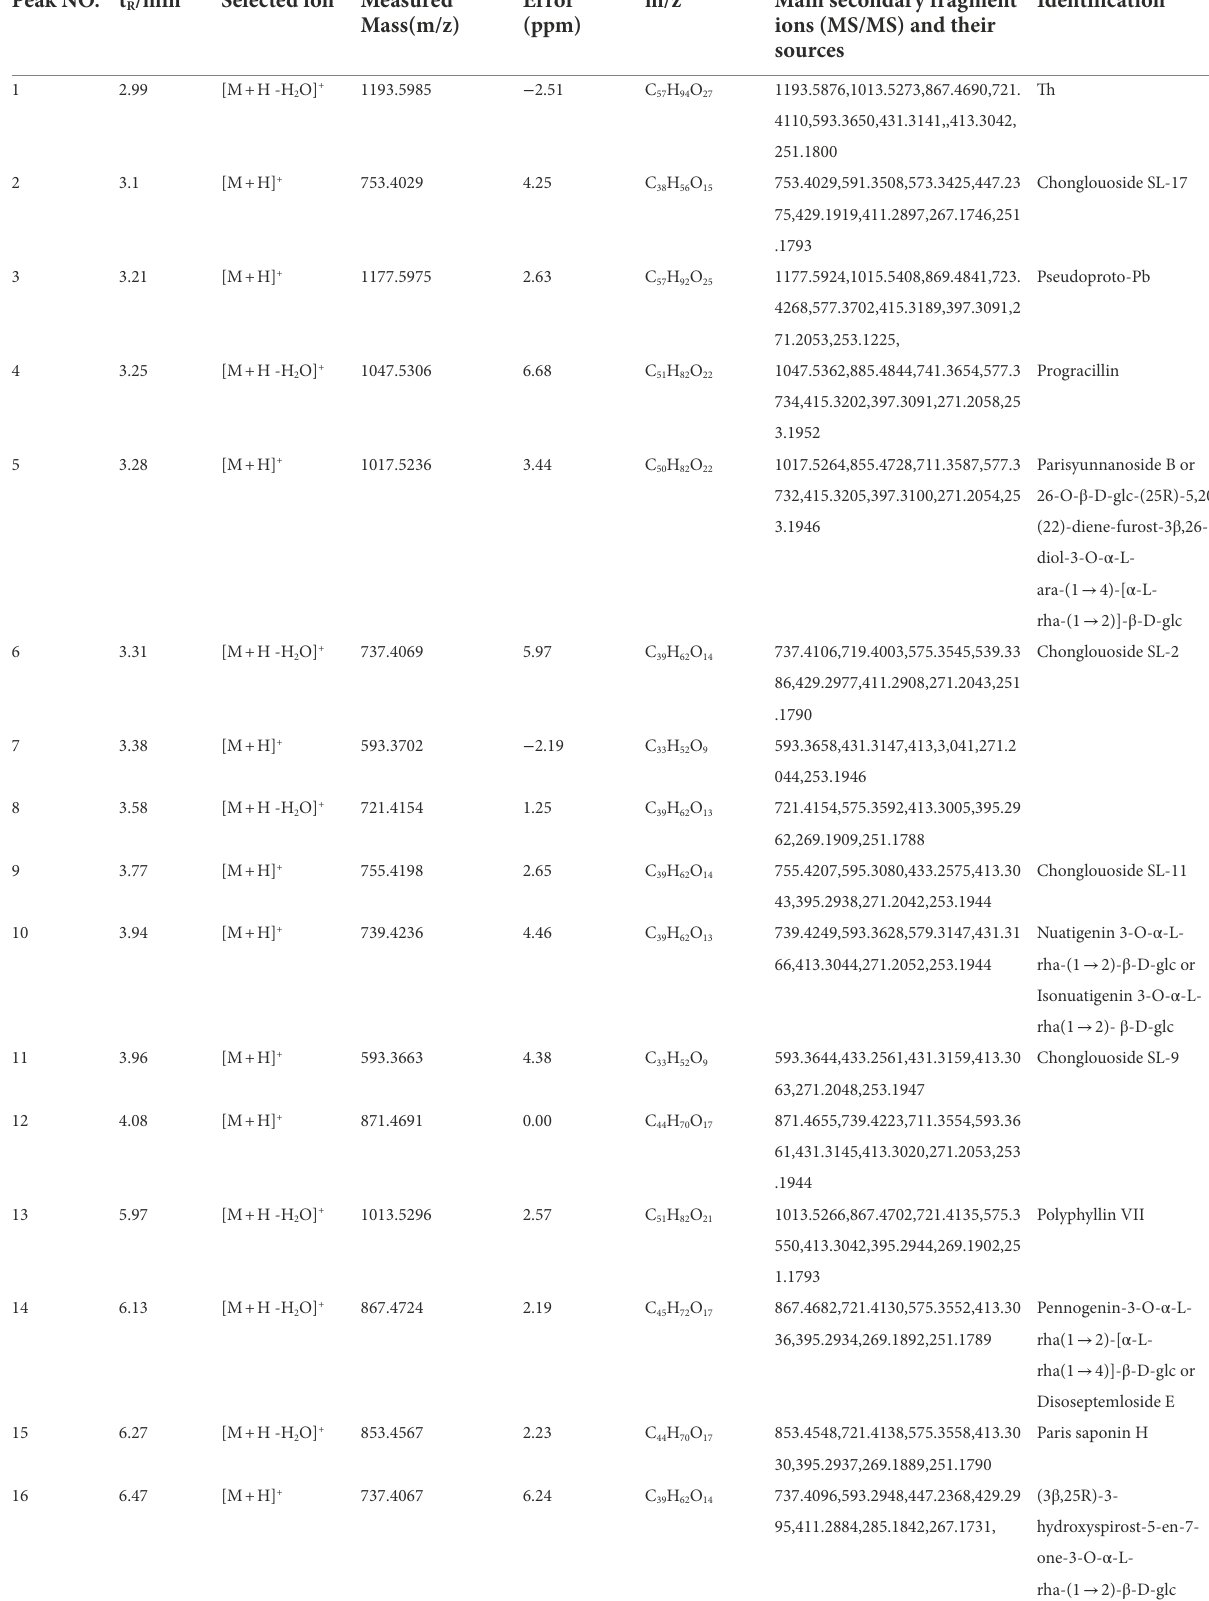
TABLE 1 Data of the identified differential 36 compounds by UPLC/Q-TOF-MS. Peak NO. t R